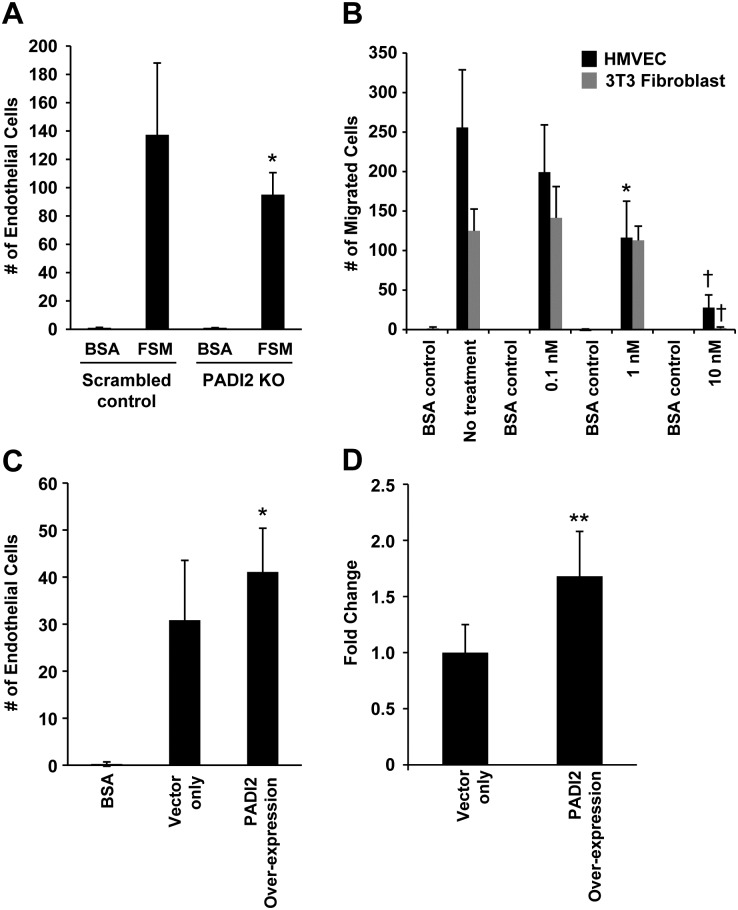
In vitro endothelial cell functional assay.A) HMVEC migration in response to full serum media (FSM) was significantly decreased when cells were transfected with PADI2-specific siRNA compared to scramble siRNA control. Started with seeded 20,000 cells per well; Basal medium containing 0.1% BSA is used as negative control. We did not find any difference in endothelial cell proliferation (S5 Fig). B) HMVEC migration in response to FSM was significantly decreased upon treatment with 1mM Cl-Amidine, a PADI inhibitor, compared to DMSO treated control. We observed no effect in 3T3 fibroblast cell migration when treated with Cl-Amidine. * indicates P < 0.05. † Treatment with 10 mM Cl-Amidine was toxic to both cell lines. C) HMVEC migration and proliferation (D) was assessed when human PADI2 is overexpressed. We observed a significant increase in both endothelial cells migration and proliferation (D) when PADI2 is overexpressed compared to vector only transfected cells. Started with seeded 10,000 cells per well. * and ** indicates P < 0.05 and P < 0.001 respectively.